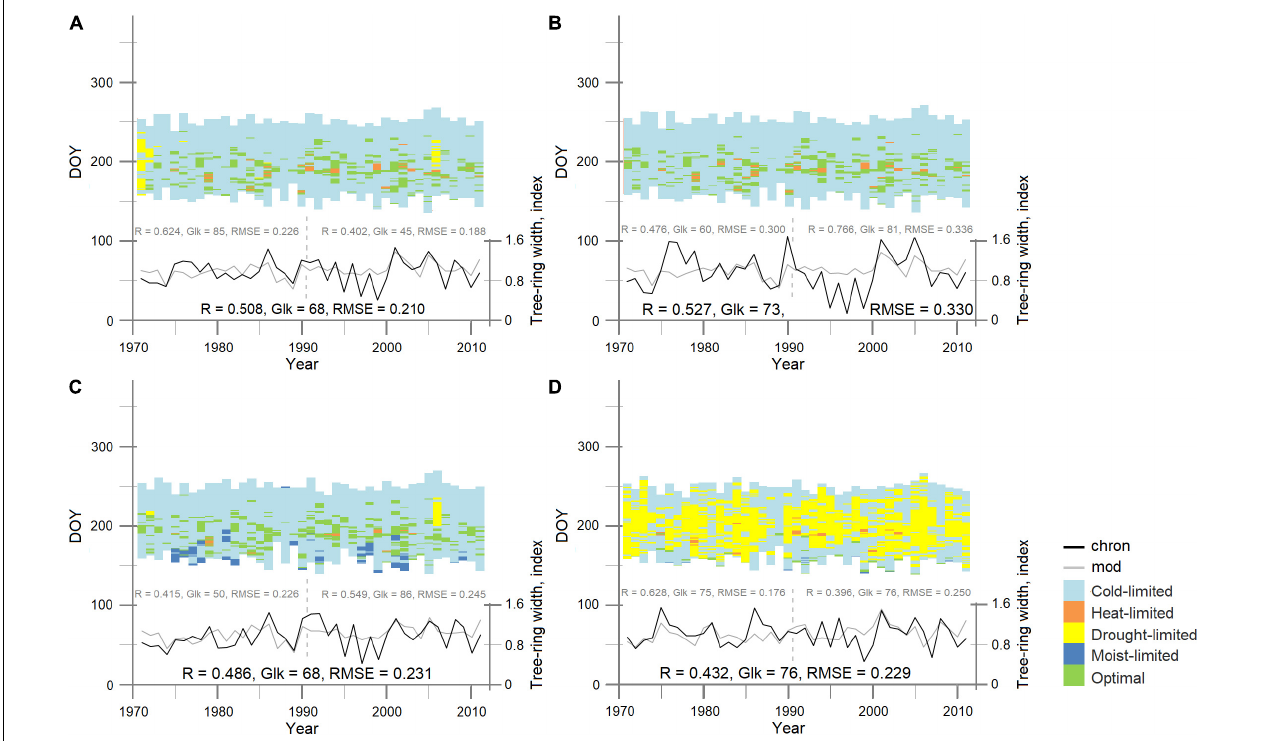
FIGURE 3 | Observed (chron—black solid line) and simulated (mod—gray solid line) tree-ring width regional (A) and site birch chronologies (B) PL, (C) TT, (D) OS, for the period 1971–2011. The vertical dashed line separates the calibration period (1991–2011) from the verification period (1971–1990). Pearson’s correlation coefficient (R), synchronicity [Gleichläufigkeit (Glk)], and root mean square error (RMSE) shown for each period/site. Each chart presents the site-specific integral growth rates for each day of the growing seasons. Colors depict the driving climatic parameters. Input model parameters for each simulated curve are presented in